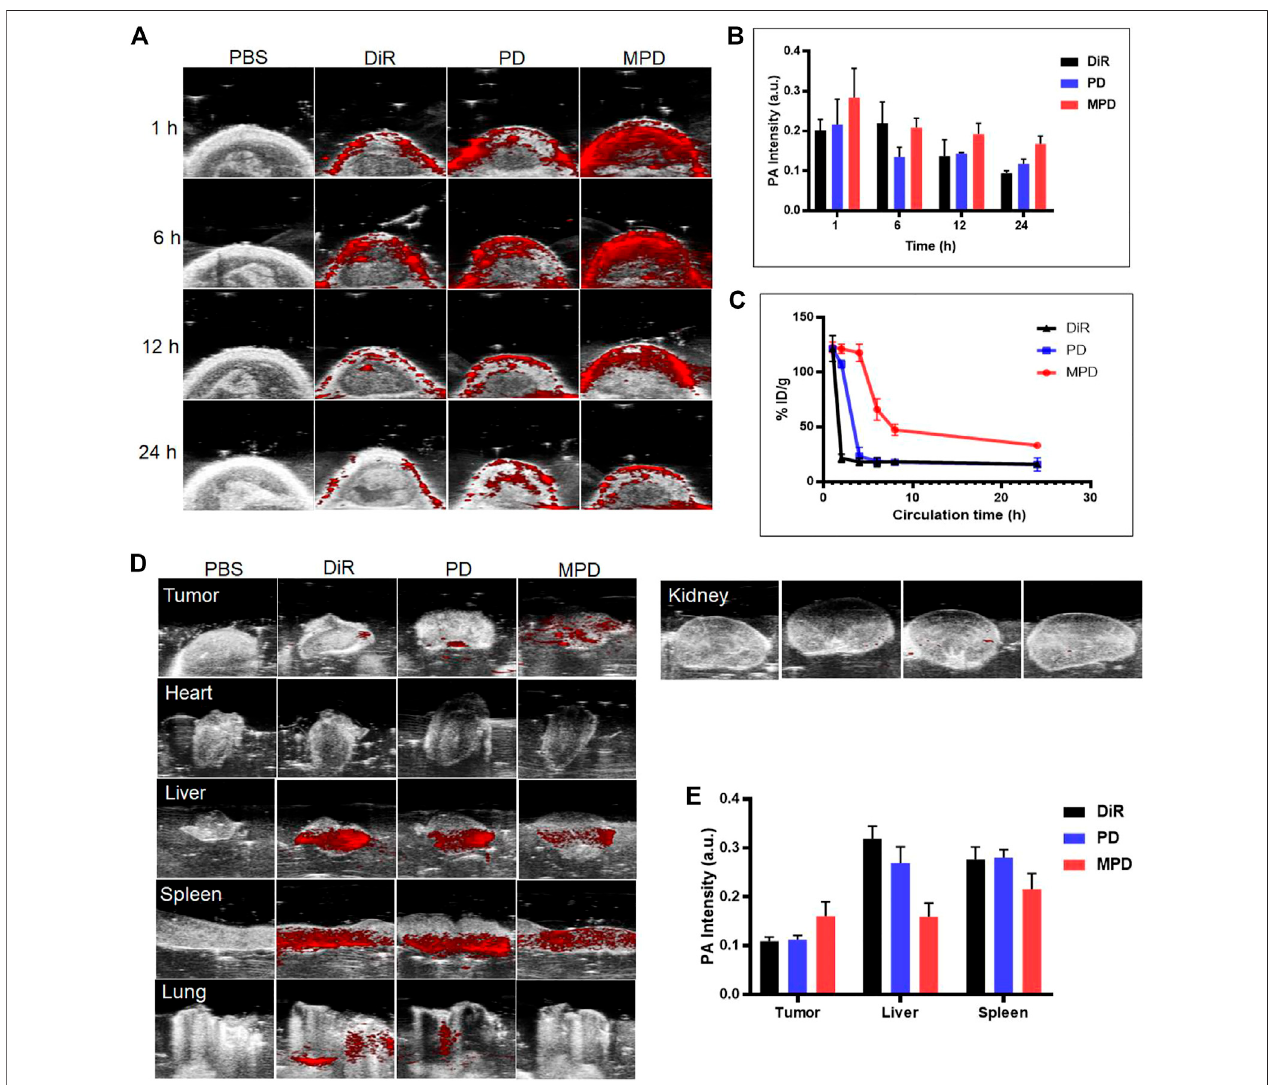
FIGURE 4 | In vivo photoacoustic imaging. (A) MPD was administered to the mice. PA imaging was applied to analyze the distribution of MPD at different time points(1,6,12,and24 h). (B) QuantitativeanalysisofMPDdistributionintumorsitesatdifferenttimepoints(1,6,12,and24 h)( n (cid:1) 3). (C) Fluorescencesignaldetection ofbloodretentionofMPD( n (cid:1) 3). (D) PAimageofmajororgansandtumorsafter24 h. (E) QuantitativeanalysisofMPDdistributionofmajororgansandtumorsafter24 h ( n (cid:1) 3).Thetumor-bearingmice wereadministered withthesame amountofsaline(200 μ L),DiR(200 μ L,1 mg/ml),and PDandMPD containingthesame amount of DiR through the tail vein. At 1, 4, 8, and 24 h after injection, the PA signals were monitored by the Vevo LAZR-X multimode imaging system using the Step and Shoot modes with 100 angles and 15 pulses per angle. Mice were then sacri fi ced 24 h after injection to check the bioelimination in different organs and tumors. Data were analyzedandquanti fi edbyVevoLAB3.2.0software.Fortheevaluationofthecirculationlifetime,thetumor-bearingmicewereinjectedwithsaline,DiR,andPDandMPD containing the same amount of DiR through the tail vein. At 1, 2, 4, 6, 8, and 24 h after injection, the DiR content in the blood was collected and analyzed with a multifunctional microplate reader (Tecan In fi nite Pro,